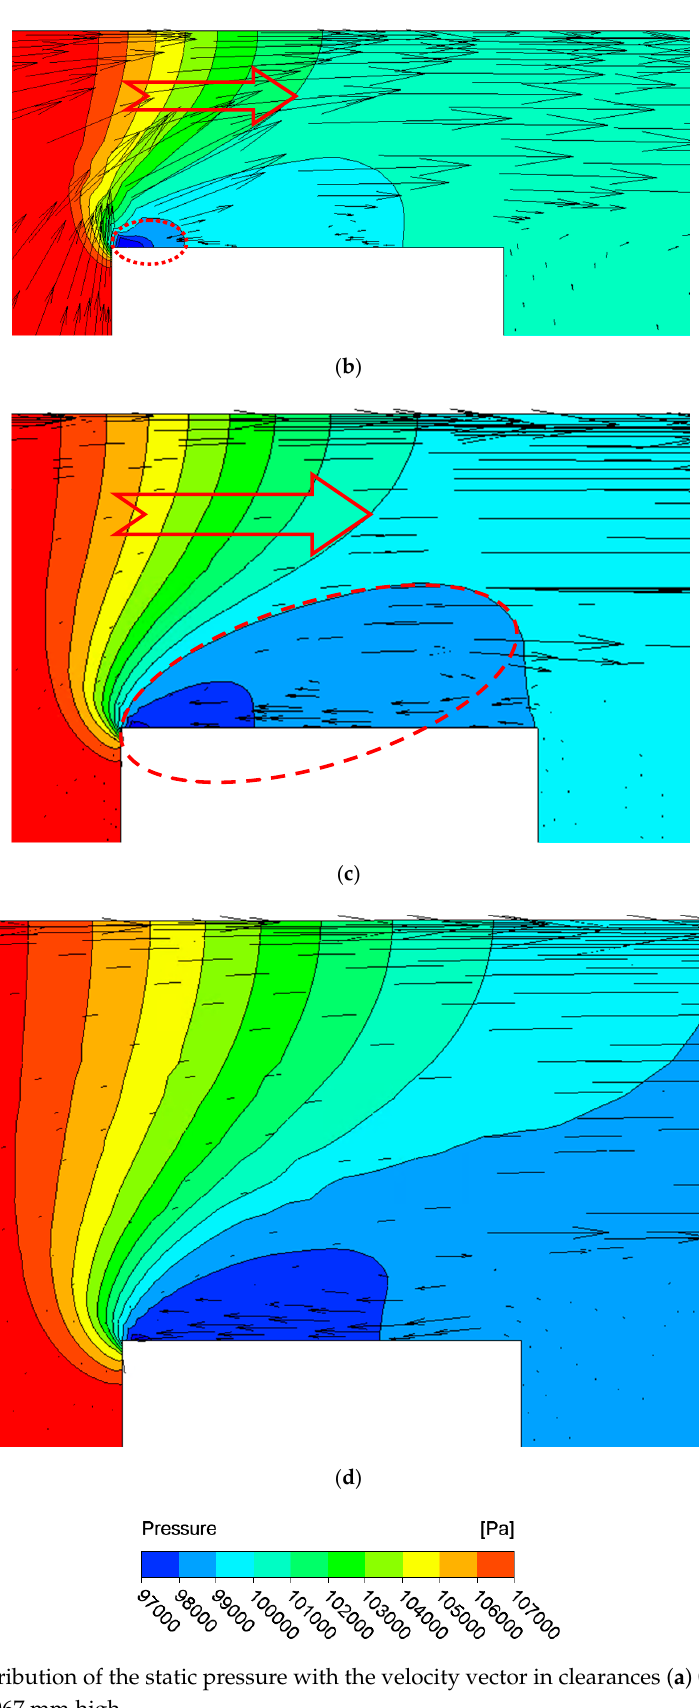
Figure 11. Distribution of the static pressure with the velocity vector in clearances ( a ) 0.362, ( b ) 0.542, ( c ) 0.752, ( d ) 1.067 mm high.